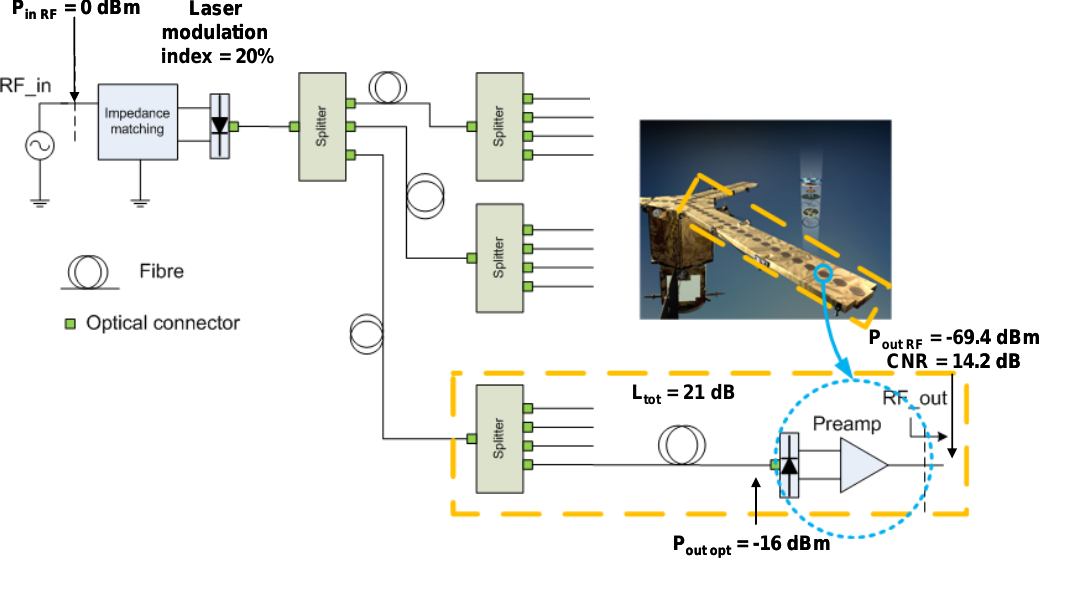
Figure 9. Concept block diagram of the implementation network in fibre optics